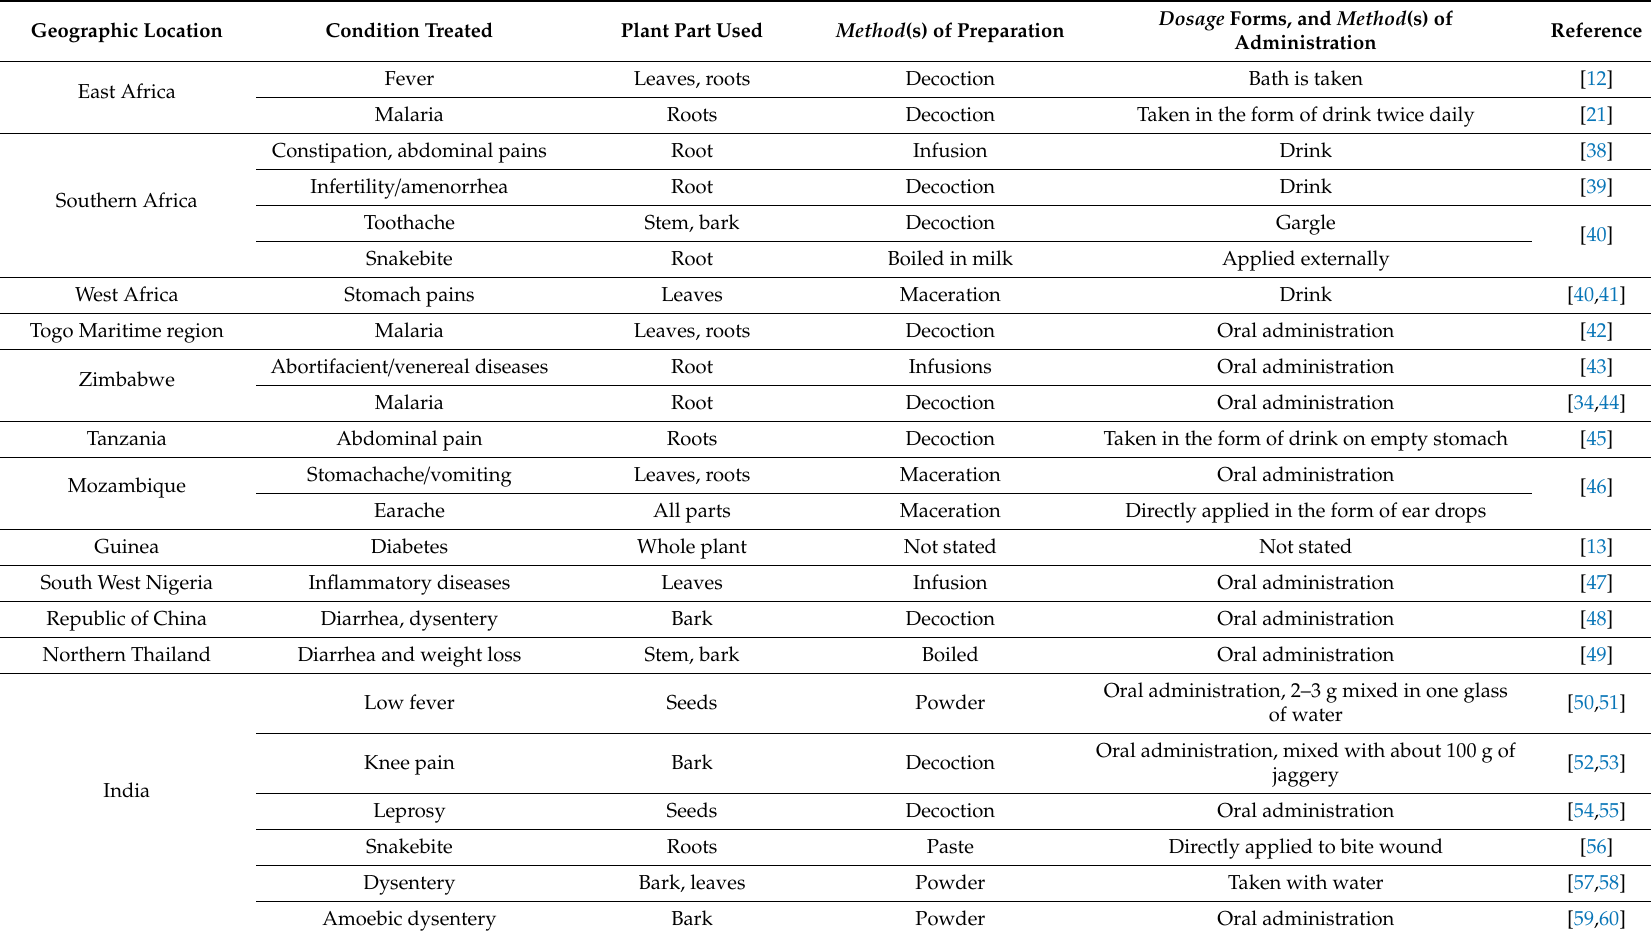
Table 2. Common traditional uses of H. pubescens throughout di ff erent parts of the